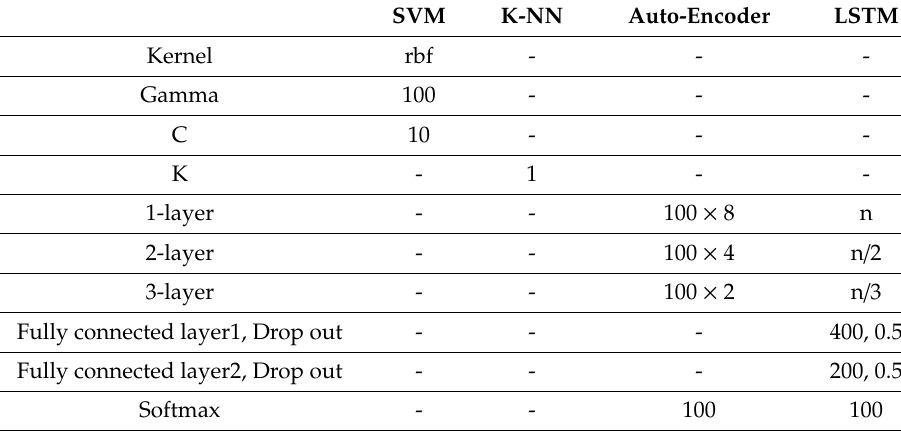
Table 5. Hyperparameter set according to each